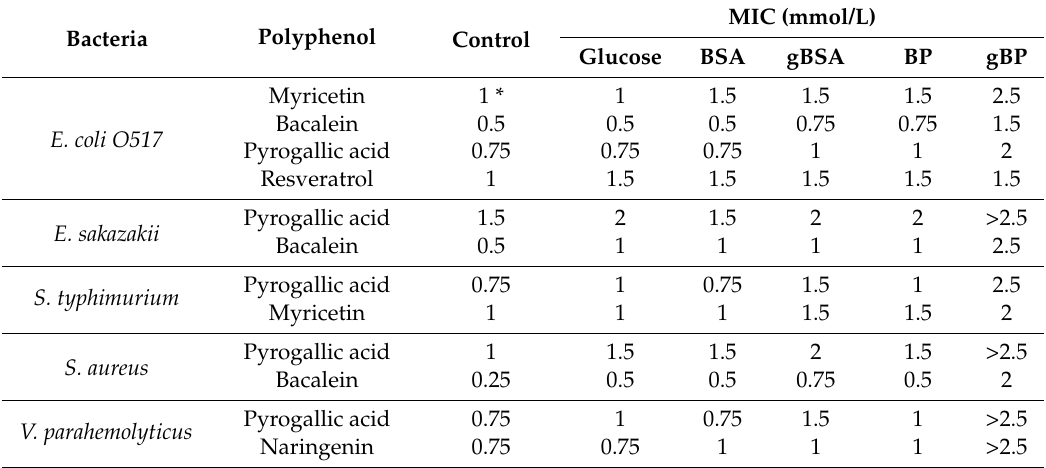
Table 4. Antibacterial activities of polyphenols in different